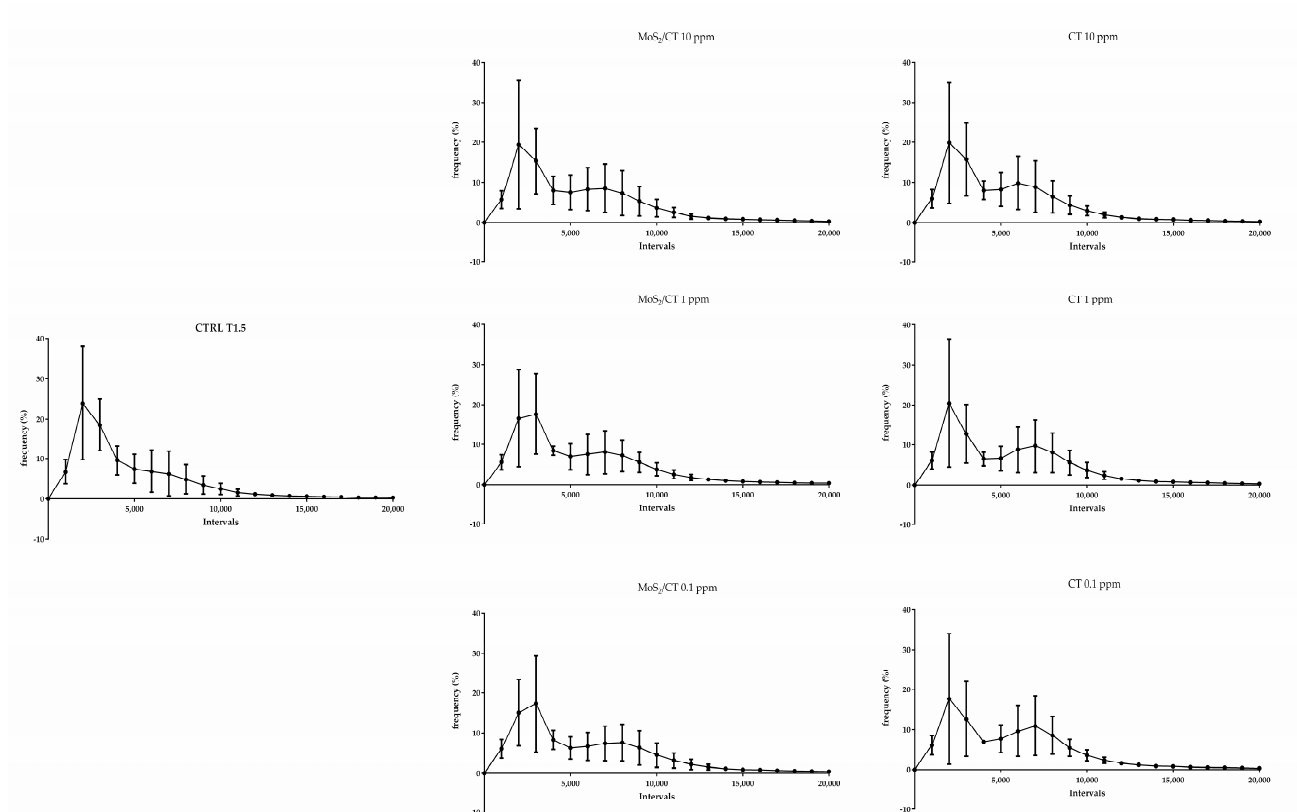
Figure 3. Flow cytometry analysis of intracellular calcium concentration. The graphs show the frequency of spermatozoa emitting a specific fluorescence intensity, which was subdivided into intervals ranging from 0 to 20,000 a.u. Capacitation was performed up to 1.5 h. Fluo 4-AM was used in combination with PI. Three independent technical and biological experiments were performed ( n = 3).